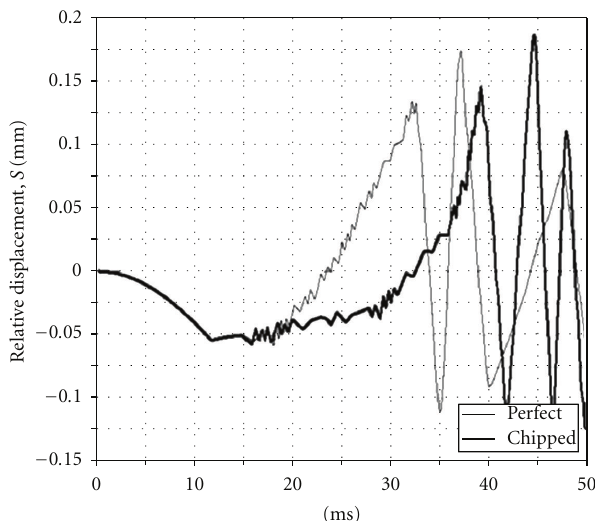
Figure 6: Relative displacement S along the line of action on stage 2 with the initial conditions: input shaft, 167.5 rad/s; intermediate shaft, − 73.5 rad/s; output shaft, 12.5 rad/s.